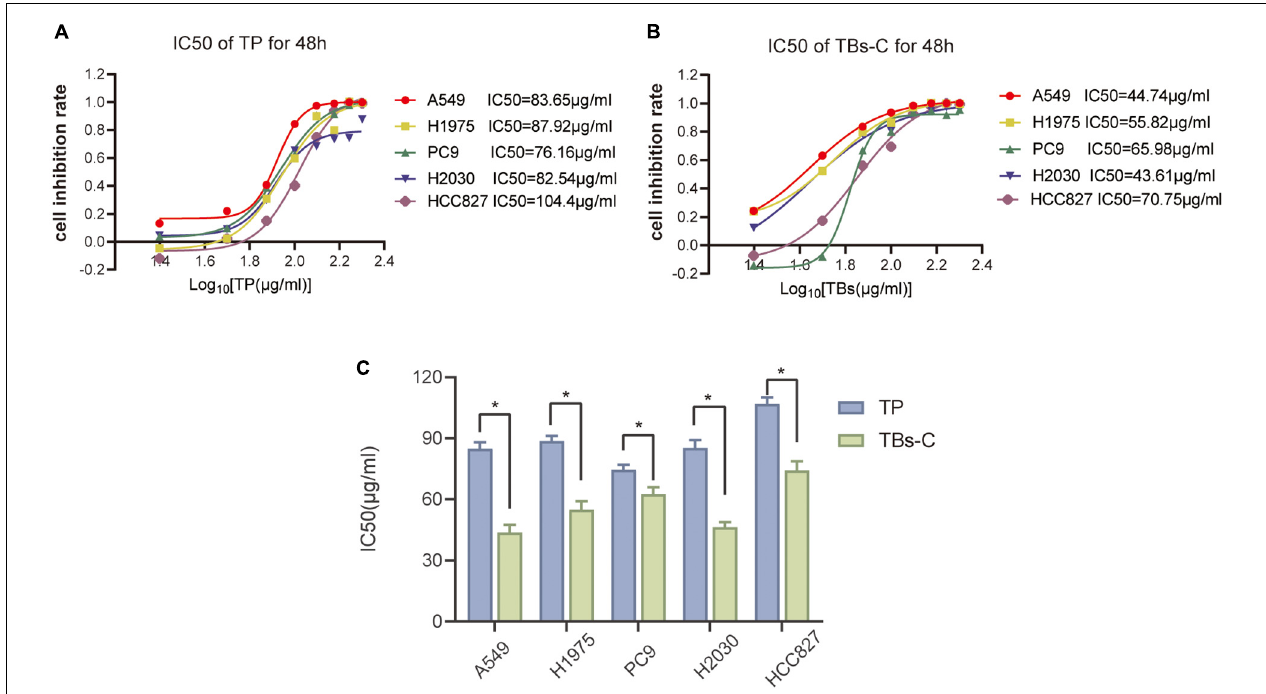
FIGURE 1 | Comparison of the anti-tumor effects of TBs-C and TP on NSCLC cells. (A,B) The experimental cells were treated with different concentrations (0, 25, 50, 75, 100, 125, 150, 175, and 200 µ g/mL) of TBs-C and TP for 48 h, and the cell viability was determined by the CCK-8 assay, with the calculation of the IC50 values. (C) The comparison of the IC50 values between TP and TBs-C in different NSCLC cell lines are presented, * p <